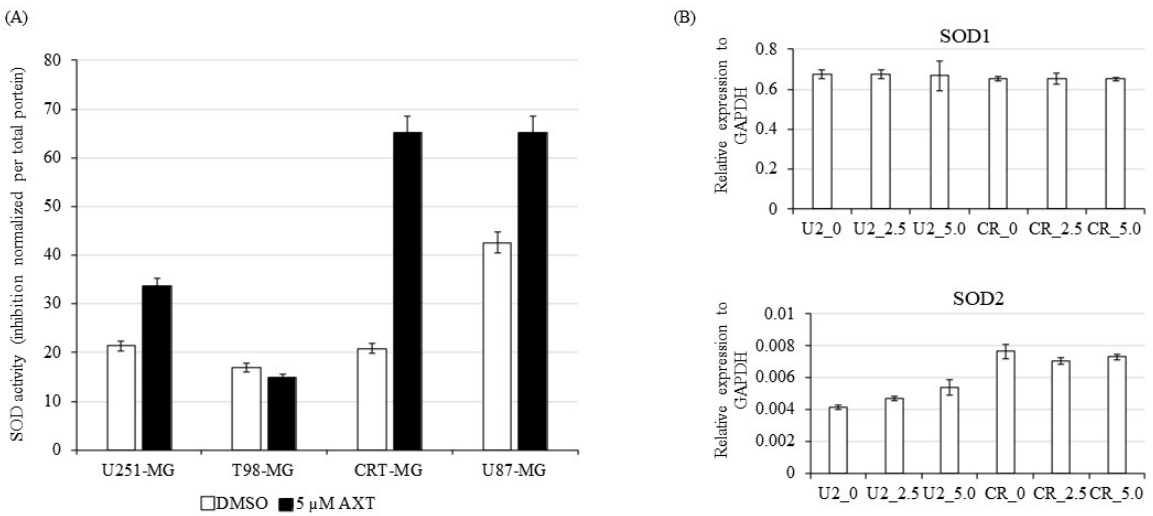
Figure 6. GBM cell lines have differential SOD activity, partially due to differential SOD2 expression. ( A ) U251-MG, T98G-MG, CRT-MG, and U87-MG cells were grown in a 6-well plate and treated with 0.1% DMSO or 5 µ M AXT for 24 h in serum-free media before harvesting. After lysis, SOD activity was assayed by kit. Activity of lysates was normalized by total protein content of each treatment. Experiments were performed in three independent replicates, and means with error bars for standard deviation are presented. (B) SOD1/2 expression in U251-MG and CRT-MG treated for 0.1% DMSO (0), 2.5 µM AXT, or 5.0 µM AXT for 24 h, which were then harvested, RNA extracted, and